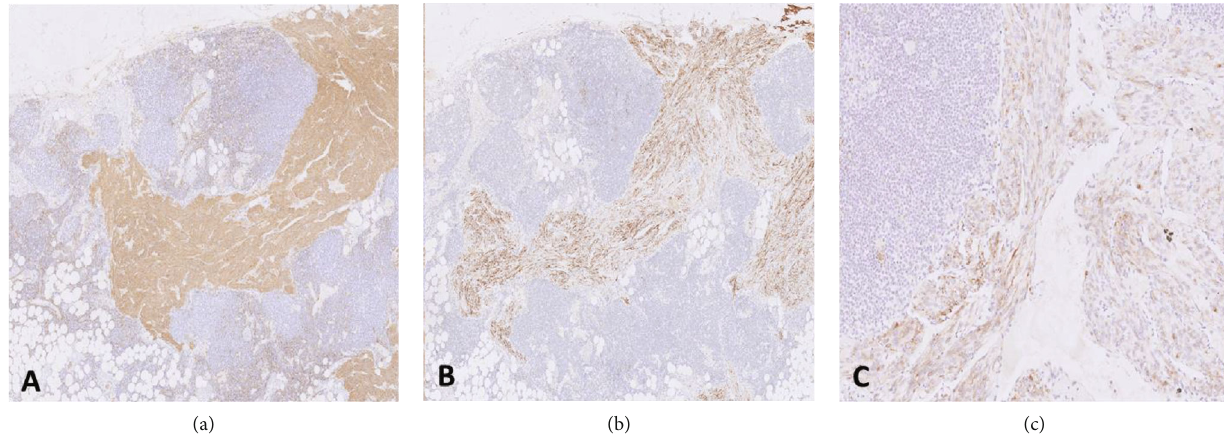
Figure 2: Positive immunohistochemistry of the spindle cell bundles with (a) desmin (10x), (b) SMA (10x), and (c) HMB45